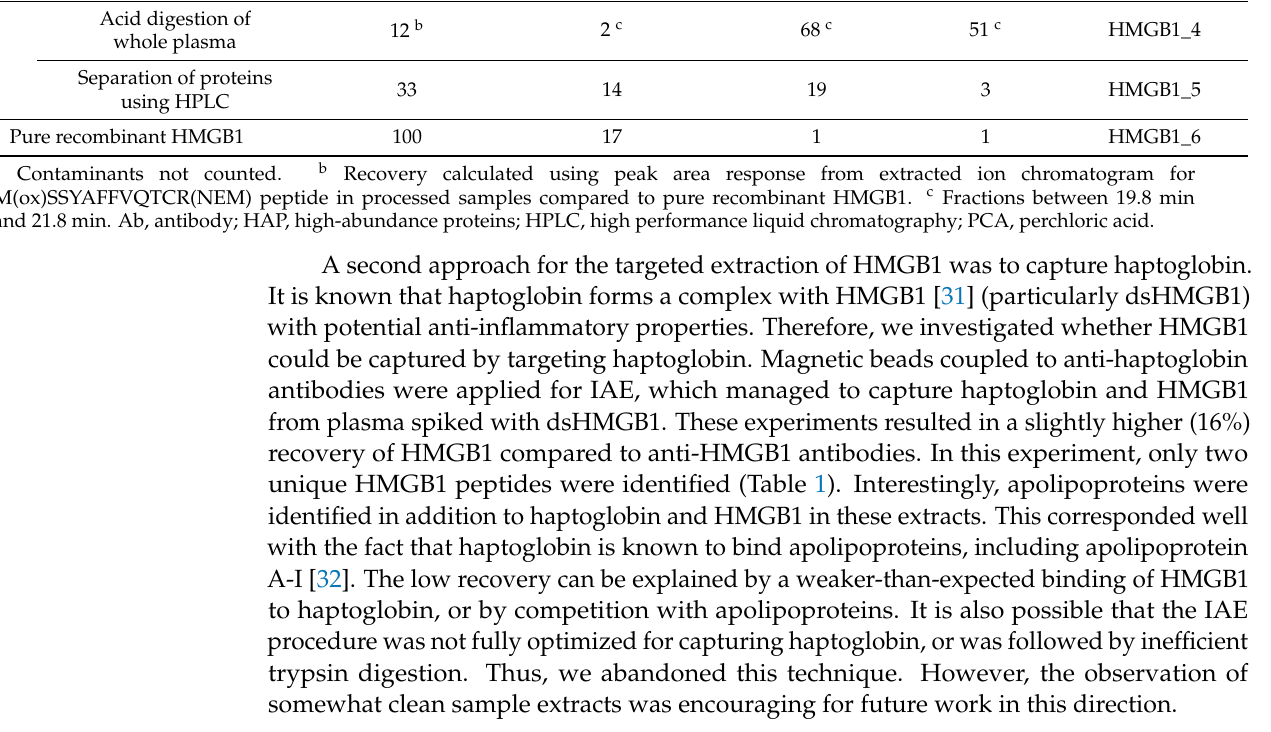
Sample Preparation